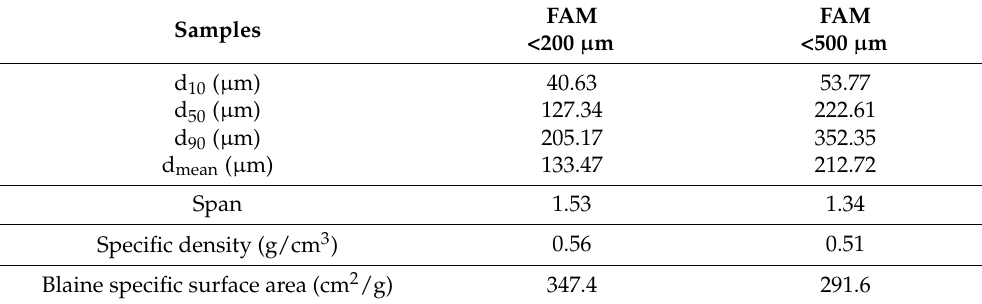
Figure 2. Particle size distribution of the fly ash microspheres. Table 3. Statistical parameters (d 10 , d 50 , d 90 , and d mean ), Span and Blaine specific surface area of